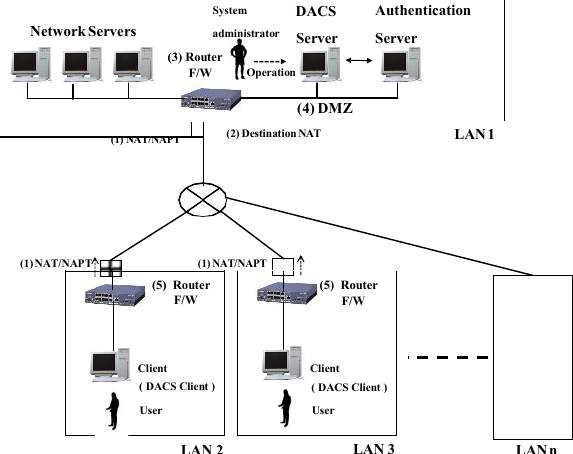
Figure 8. Basic System Configuration of wDACS system